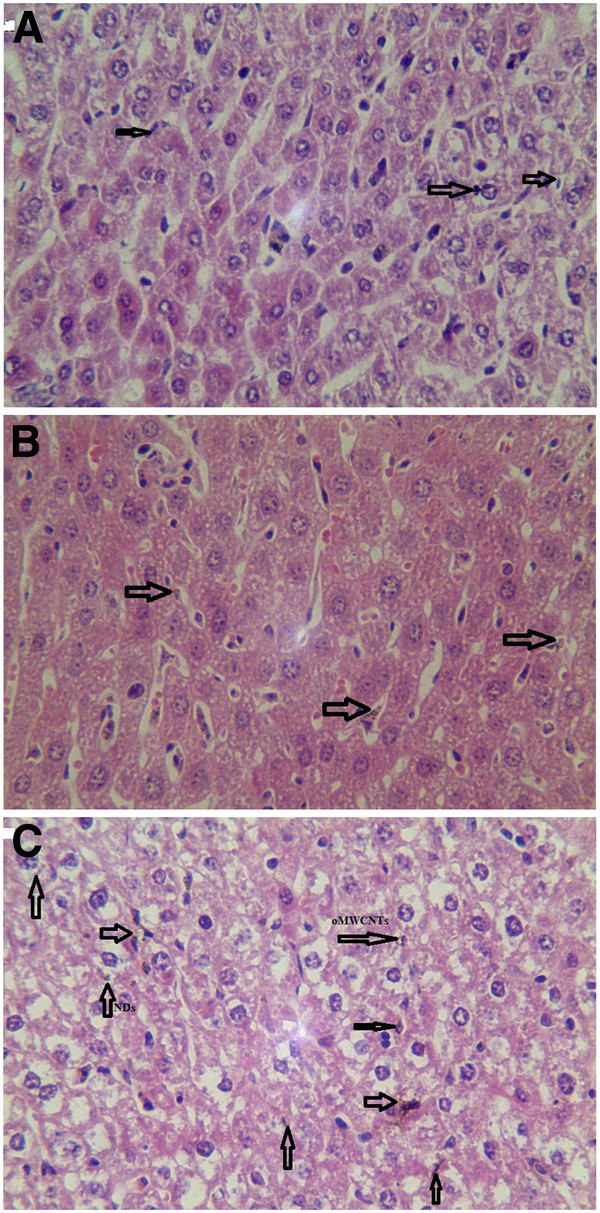
The histology of liver tissues (×20). (A) oMWCNTs, (B) NDs, and (C) oMWCNTs + NDs.